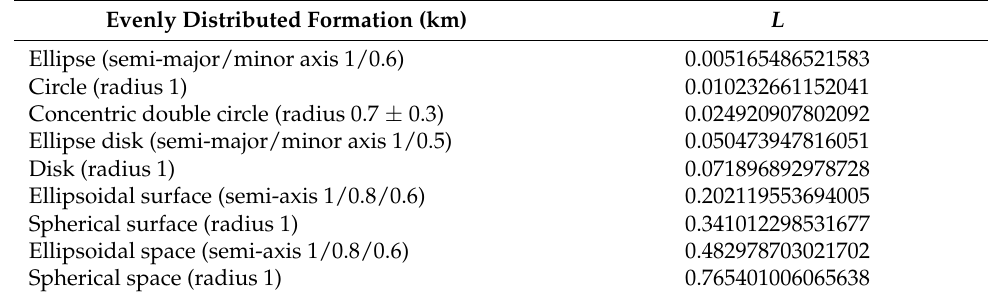
Table 3. The distribution uniformity of the cluster corresponds to different formations. Evenly Distributed Formation (km) L Ellipse (semi-major/minor axis 1/0.6) 0.005165486521583 Circle (radius 1) 0.010232661152041 Concentric double circle (radius 0.7 ± 0.3) 0.024920907802092 Ellipse disk (semi-major/minor axis 1/0.5) 0.050473947816051 Disk (radius 1) 0.071896892978728 Ellipsoidal surface (semi-axis 1/0.8/0.6) 0.202119553694005 Spherical surface (radius 1) 0.341012298531677 Ellipsoidal space (semi-axis 1/0.8/0.6)